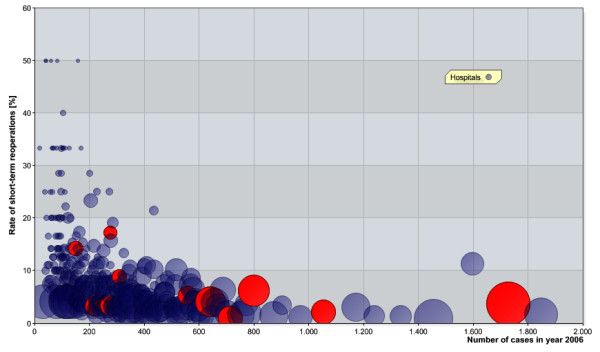
Scatter plot: Each circle stands for a hospital. Its area correlates with the number of hip joint endoprostheses implantations of the persons insured at TK. The abscissa shows the annual number of cases according to BQS [7]. Those hospitals with integrated health care contracts with TK for endoprosthetic care are marked in red.